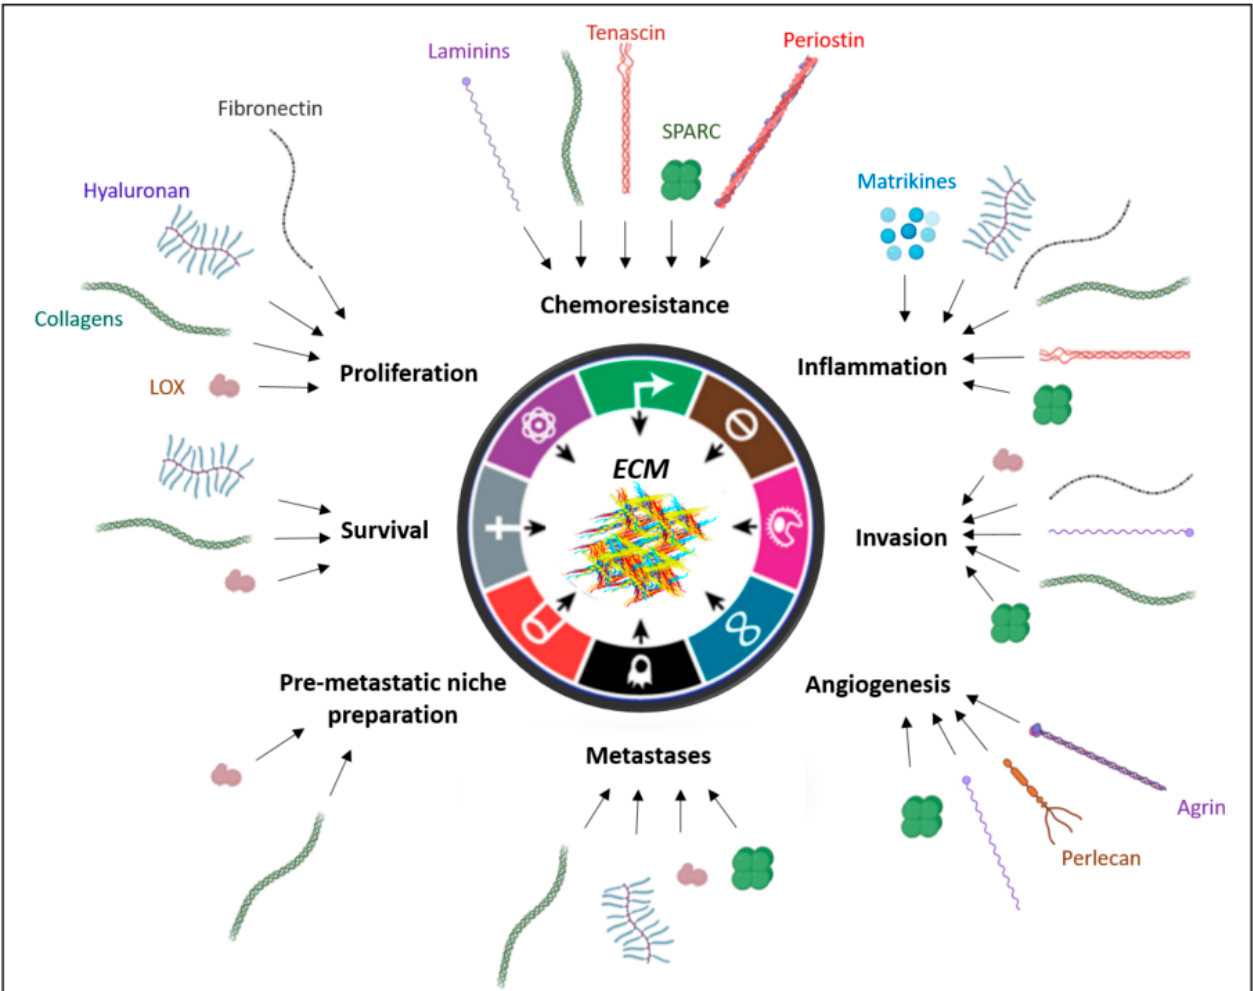
Figure 1. Schematic of the impact of ECM proteins on tumor functions. LOX: lysyl oxidase; SPARC: secreted protein acidic and cysteine rich.